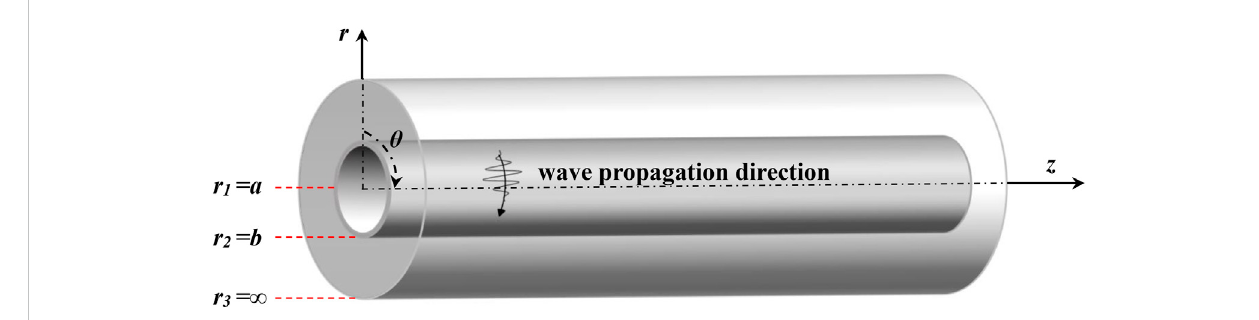
FIGURE 1 The geometry of a semi-in fi nite coated hollow circular tube in cylindrical coordinate